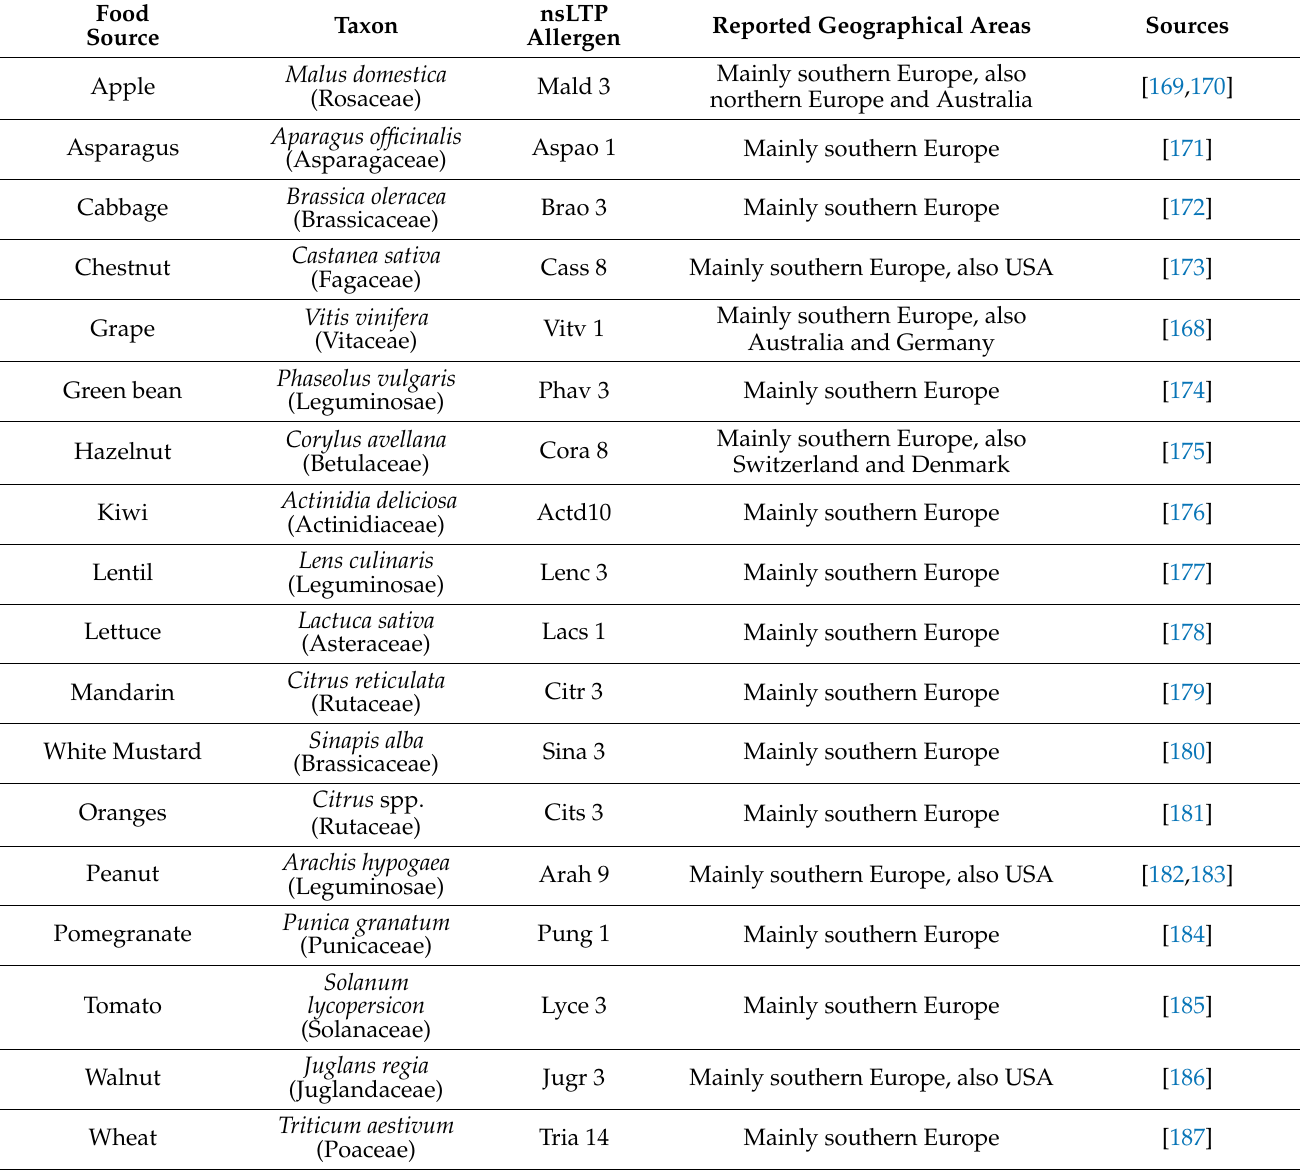
Table 4. Allergenic nsLTPs identified in different foods, with reported geographic